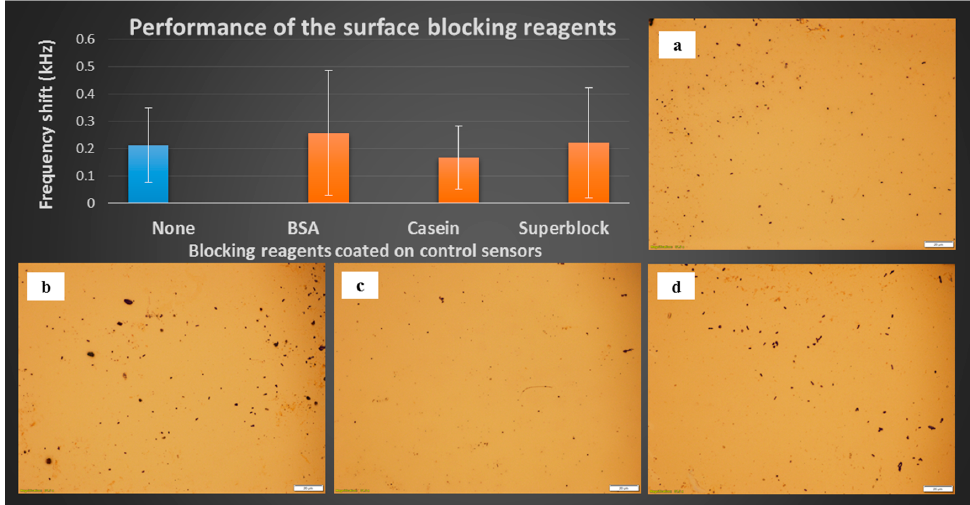
Figure 2. Resonant frequency shifts and sensor surface micrographs (scaleplate 20 μ m) after 30 min exposure to 5 × 10 8 cfu/mL S. Typhimurium on bare ME sensor platforms coated with the following blocking agents: ( a ) None, ( b ) BSA, ( c ) Casein, and ( d ) Superblock.